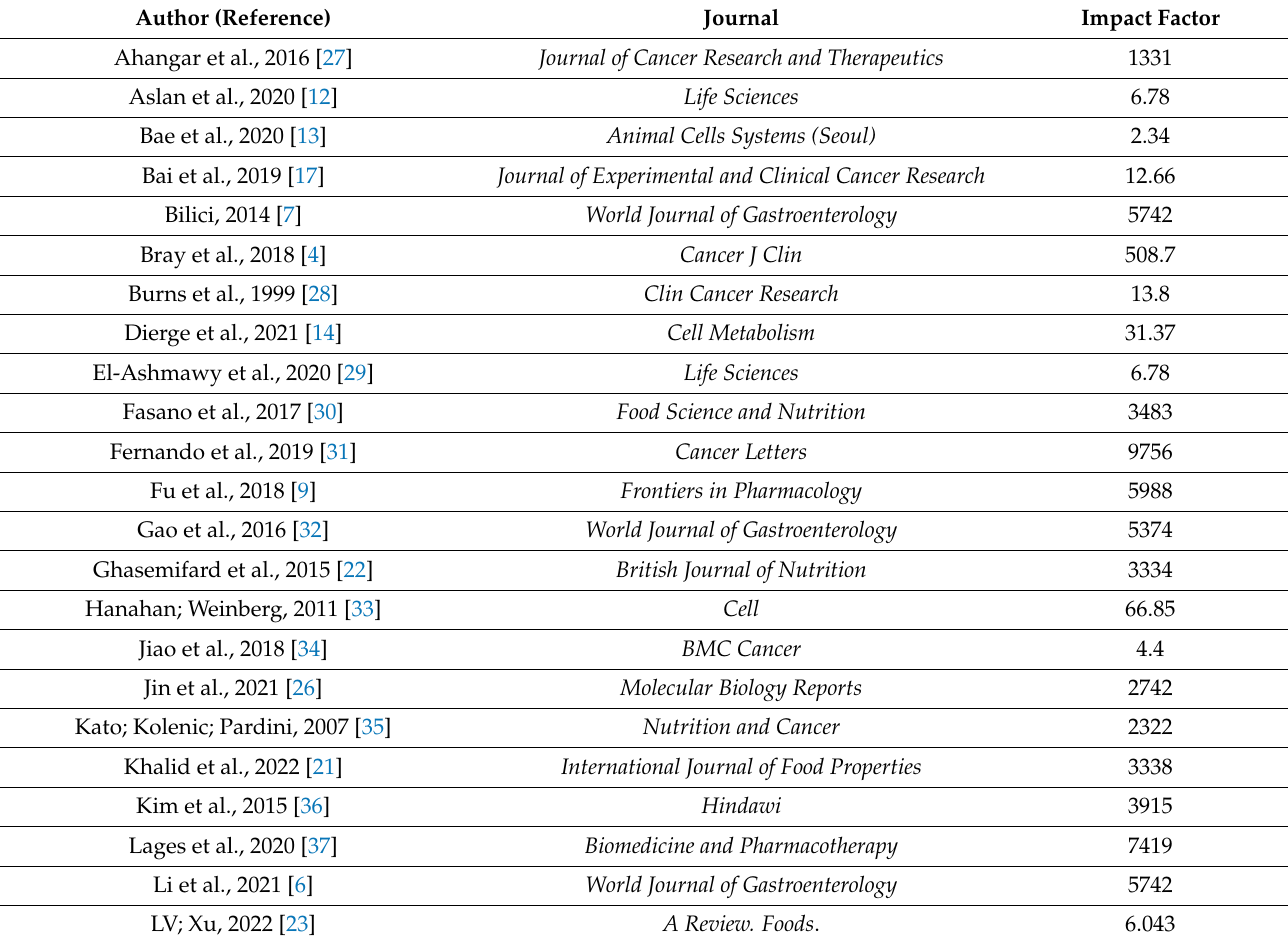
Table 1. Articles included in this review with their respective first authors, journal and impact